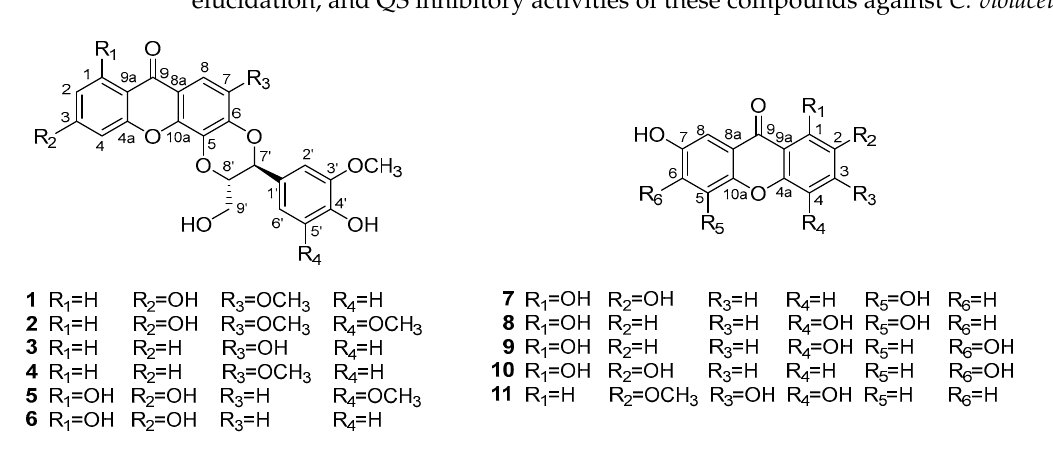
Figure 1. Structures of compounds 1 – 11 .